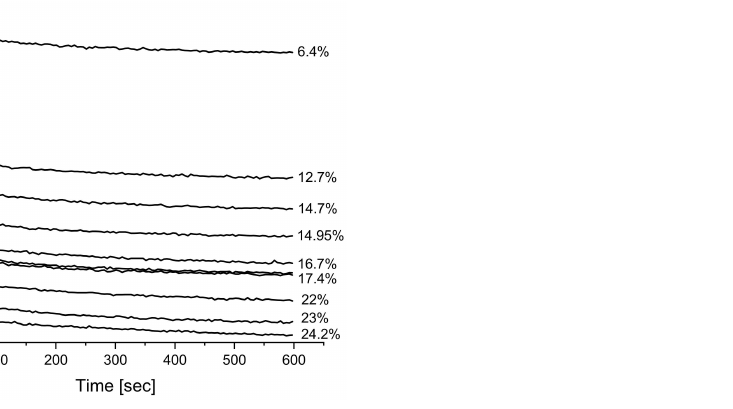
Figure 10. An overlay of relaxation tests of blend 1 at varying levels of void content mentioned in the text to the right of each curve.